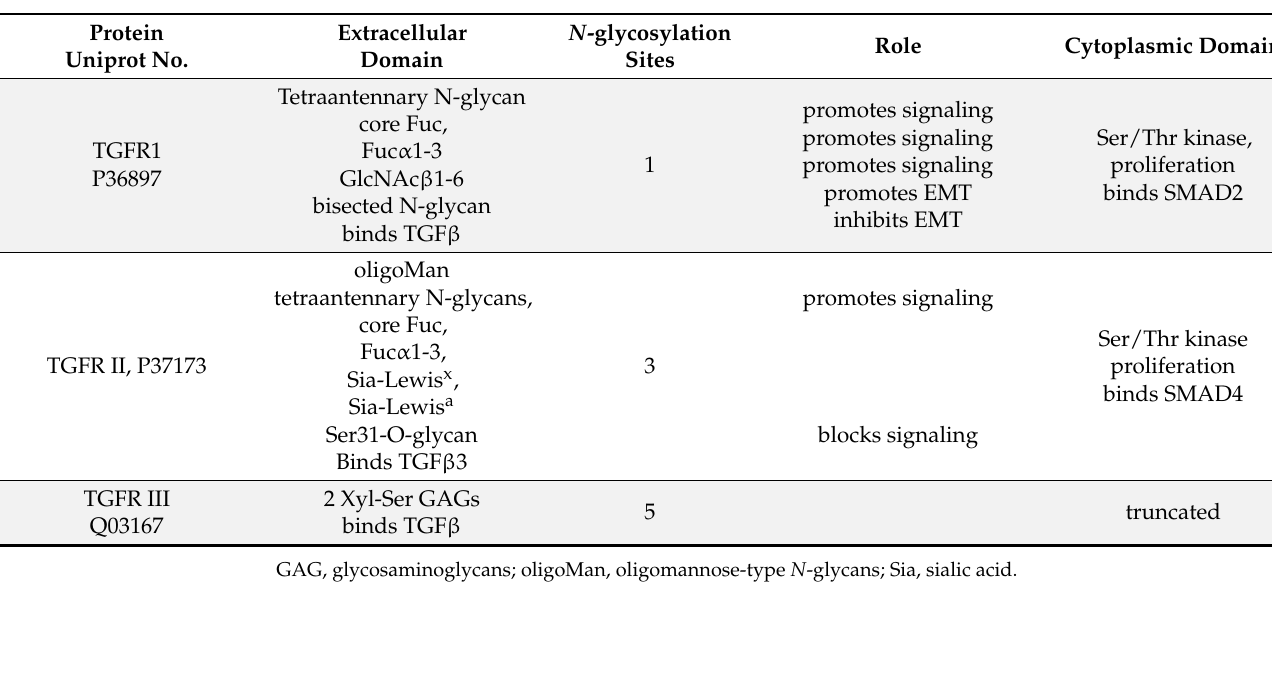
Table 4. Transforming growth factor receptors.